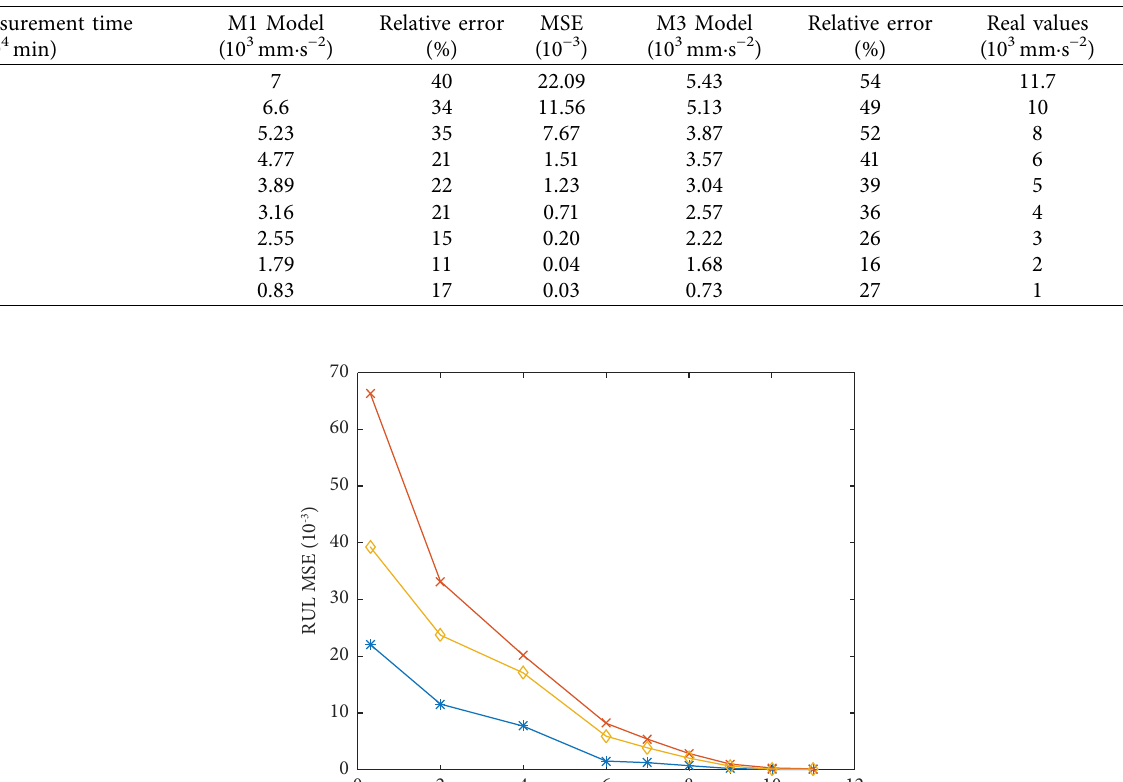
Table 6: Error analysis of RUL estimation value of the M1 model and M3 model.